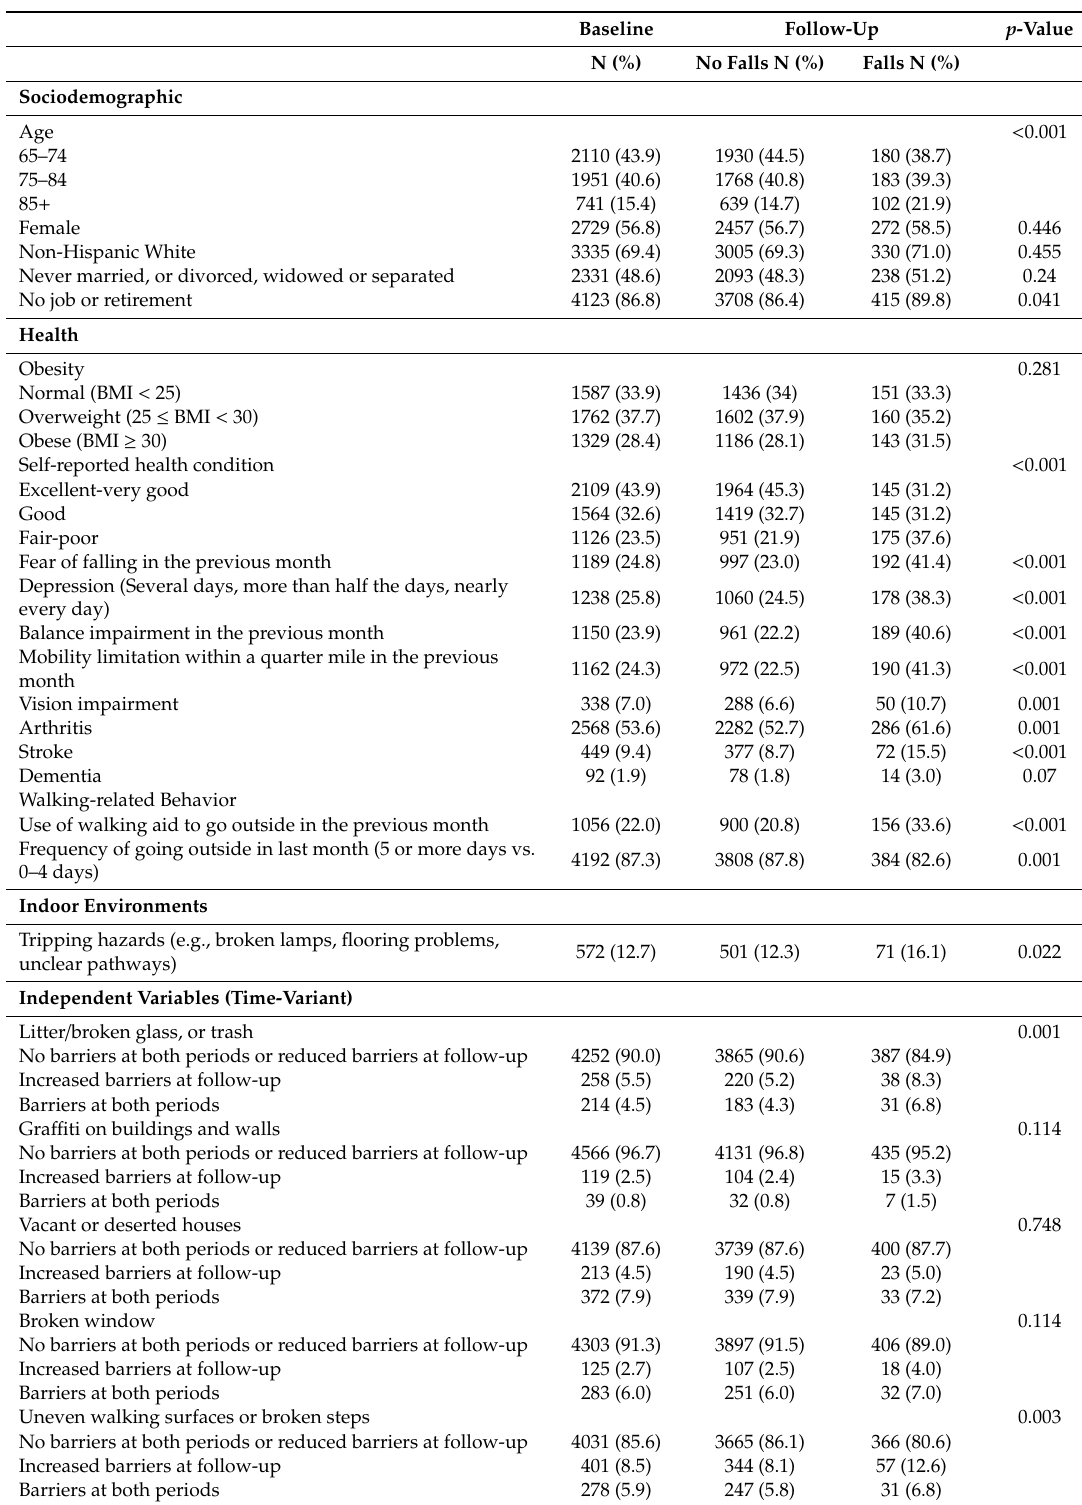
Table 1. Characteristics of study samples between non-fallers and fallers ( n =